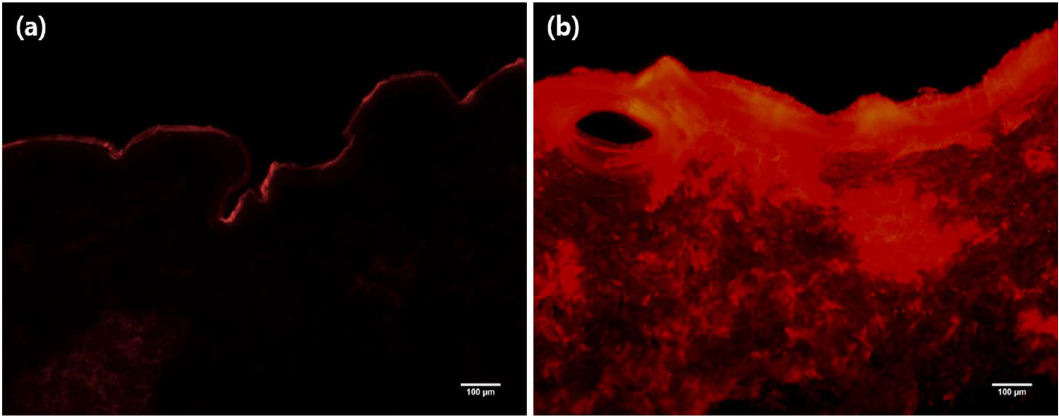
Figure 7. Histological images of cryosectioned porcine skin after SRB dye application. Dye distribution of ( a ) MLP untreated and ( b ) MLP treated porcine skin observed under fluorescent microscope .